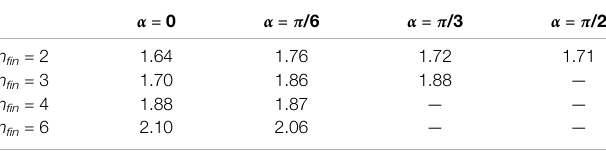
Note . K eq , average dimensionless equivalent thermal conductivity of whole cylinder; Ra , Rayleigh number; α , angle of fi ns n fi n , number of fi